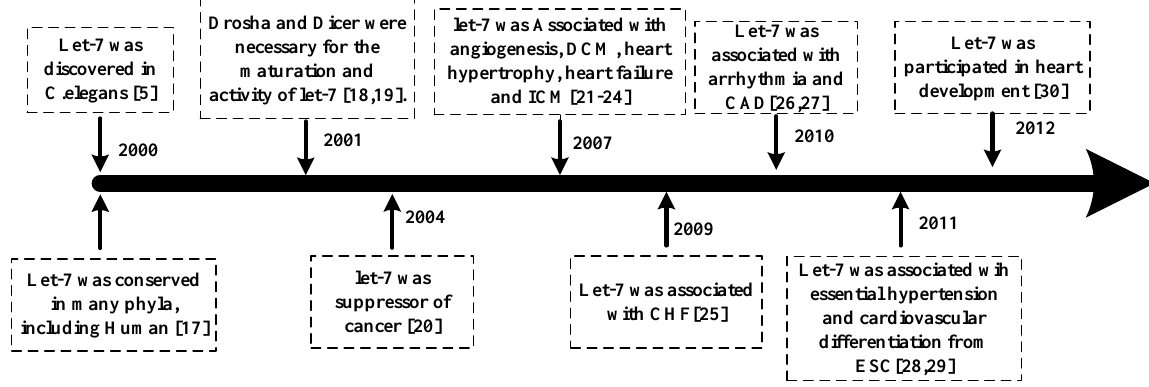
Figure 1. The timeline of let-7 discovery in cardiovascular